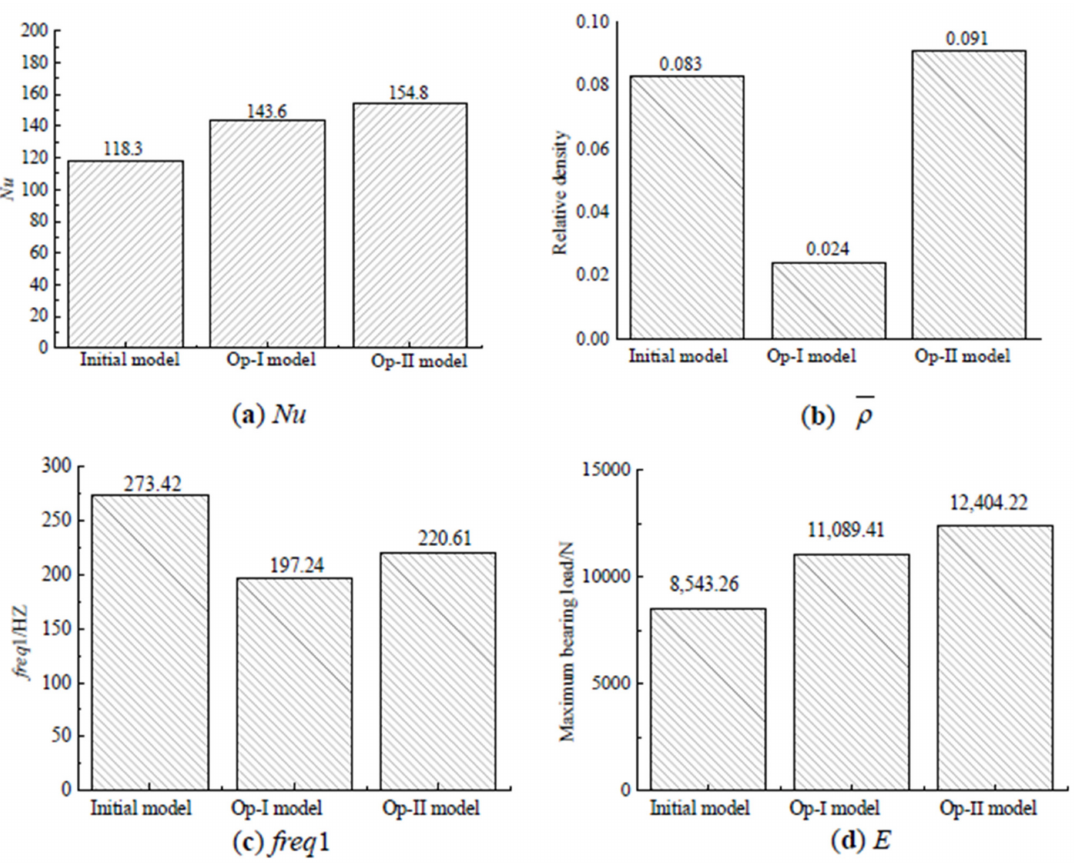
Figure 13. Comparison of the optimization results of